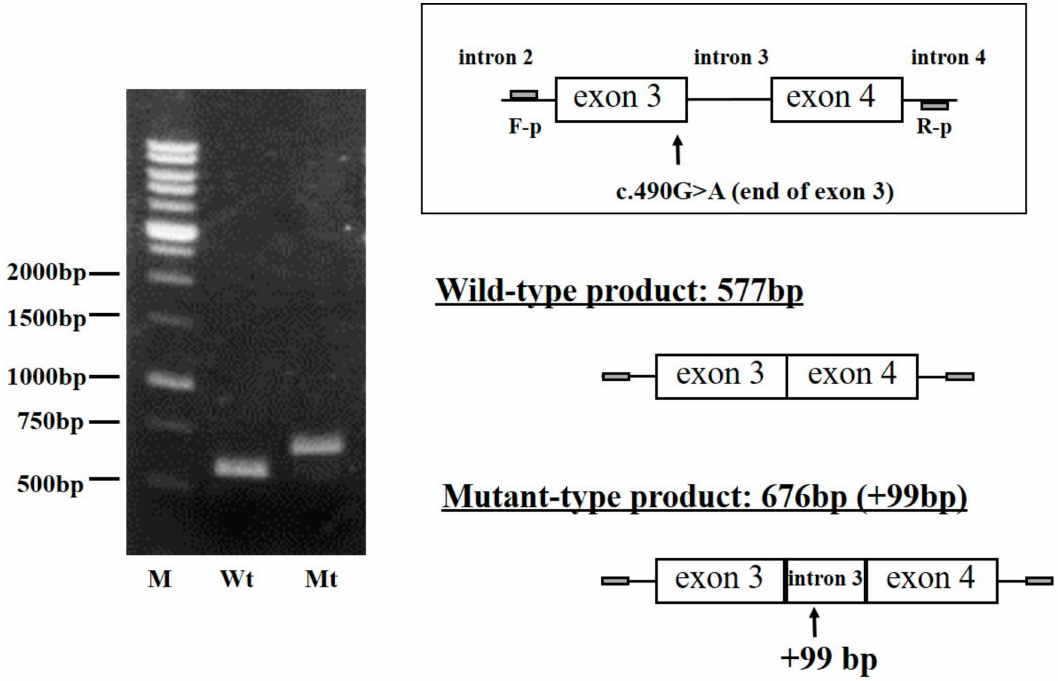
Figure 2. Analysis of fibrinogen B β -chain mini-gene transcripts in CHO cell lines. The PCR-amplified mini-genes of the Kyoto IX propositus were cloned into the pSecTaq/FRT/V5-His TOPO ® vector and transfected as described in the Materials and Methods section. Upper right : Construction of the mini-gene by amplification with the forward primer (F-p) and reverse primer (R-p). Left : RT-PCR products were separated on a 1% agarose gel. Lower right : Schematic structure predicted from sequencing for RT-PCR-amplified mini-gene products. Mini-gene was constructed from intron 2 to intron 4. Wt: RT-PCR amplified products from wild-type mini-gene-derived mRNA. Mt: RT-PCR amplified products from aberrant mini-gene-derived mRNA. M: Molecular size markers.